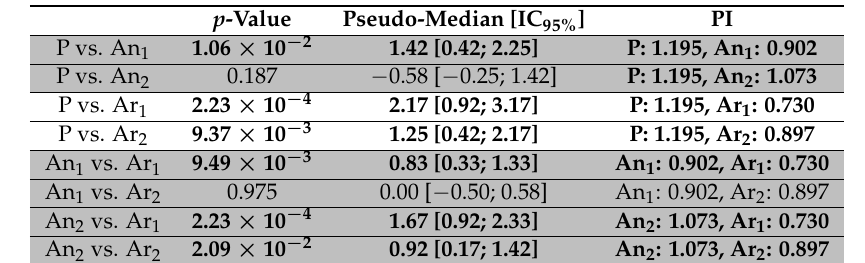
Table 4. Wilcoxon Signed Rank bilateral tests for paired samples on the inter-site level. p -values have been corrected by the FDR method and are shown in Figure 3. The pseudo-medians of the daily activity hours differences and their 95% confidence interval as well as the associated persistence indices (PI) are also presented. Significant differences are in